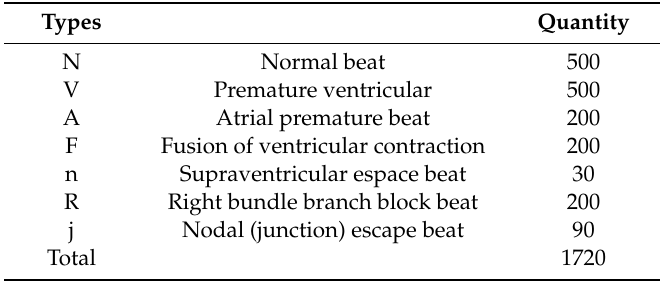
Table 9. The details of the categories on INCART